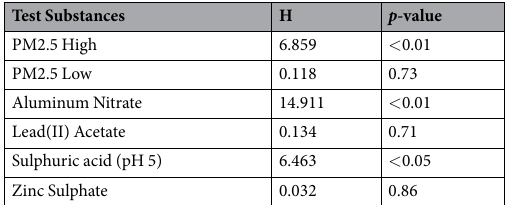
Table 3. Result of the non-parametric Kruskal-Wallis statistical analysis. H value shows the discrepancies between the rank sums of BSS from one treatment with the control; higher means more significant. High PM2.5, pH 5, and aluminum shows significant change in the snails’ behavior ( p <